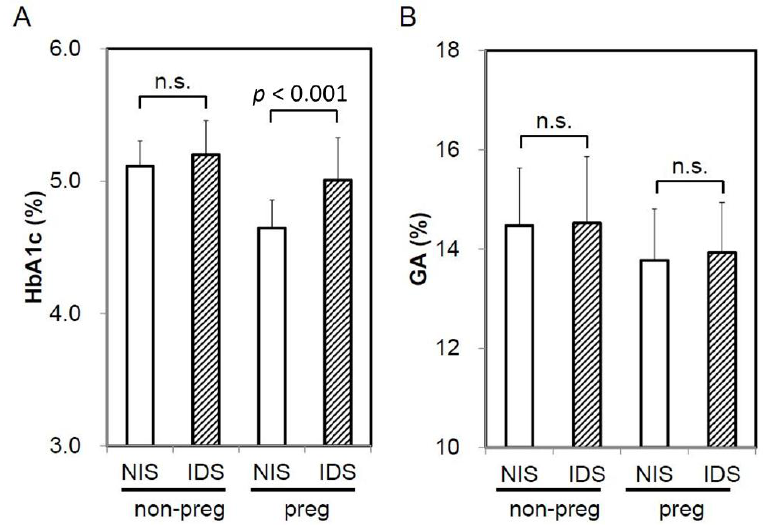
Figure 1. Influence of iron deficiency on HbA1c and GA levels in non-pregnant and pregnant women. Comparison of HbA1c ( A ) and GA ( B ) between IDS and NIS in non-pregnant women and pregnant women were shown. NIS, normal iron state; IDS, iron deficient state; non-preg, non-pregnant women; preg, pregnant women; n.s., not significant.